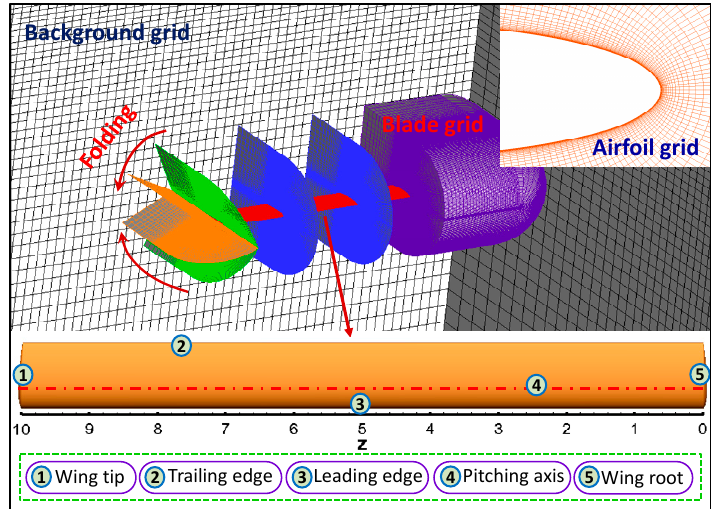
Figure 1. Schematic of moving ‐ embedded grids and geometric shape of the finite wing.